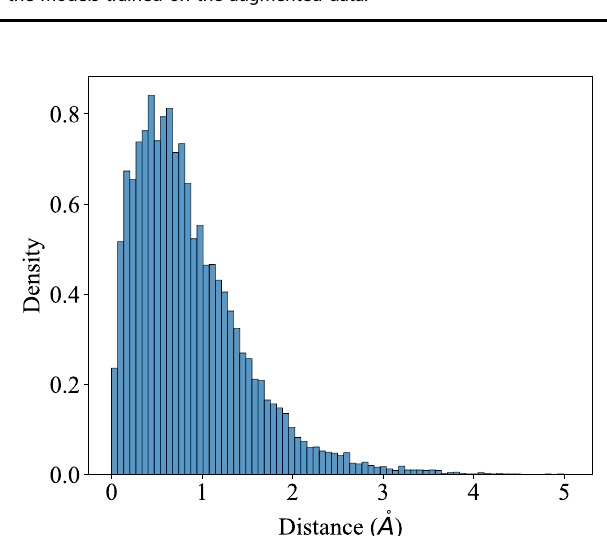
Fig. 5 Distribution sampled for perturbation. Distribution of the displacement of atoms during structural relaxation in three separate GA runs. The displacement is measured by the change in fractional coordinates multiplied by the lattice vector matrix of the relaxed